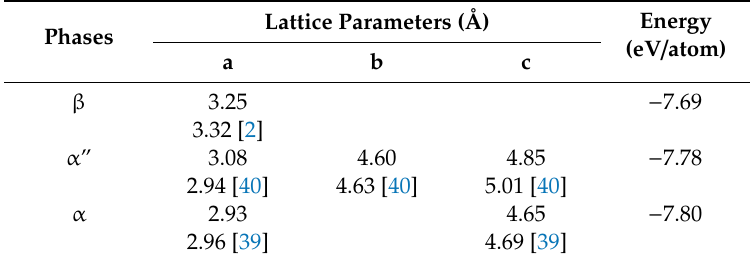
Figure 2. The intrinsic microstructure evolution of martensite ( α ” and α ) from { 332 }(cid:104) 113 (cid:105) β TB through the initial ( a ), intermediate ( b – d ), and the final ( e ) atomic configurations. The energy profiles obtained by the algorithms of the conjugate gradient, quasi-Newton, and G-SSNEB are shown in ( f ) for comparison. (cid:16) (cid:17) Yellow and black spheres represent the atoms in the adjacent 110 and ( 0001 ) α planes, respectively. β The unit-cells are outlined by the red lines. Table 2. The lattice parameters and energies of various Ti